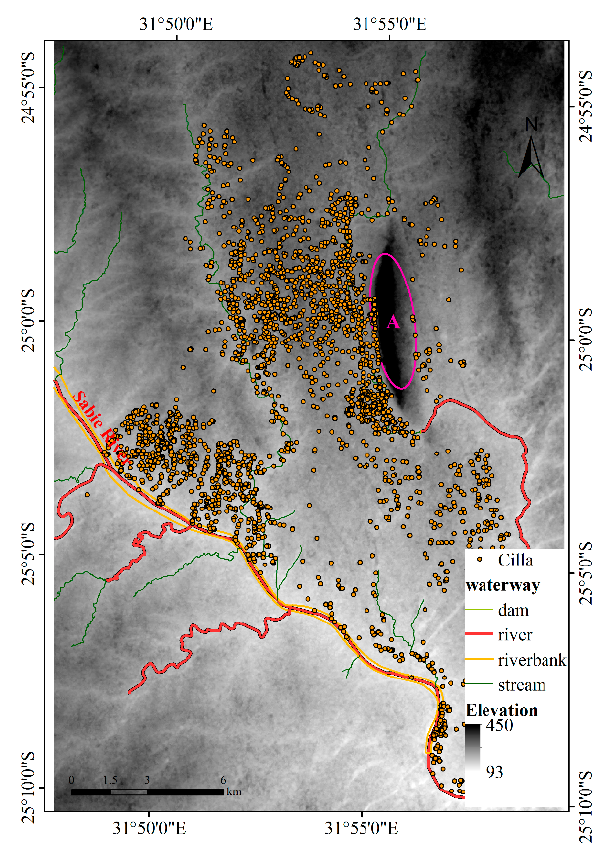
Figure 5. The position locations for Cilla.